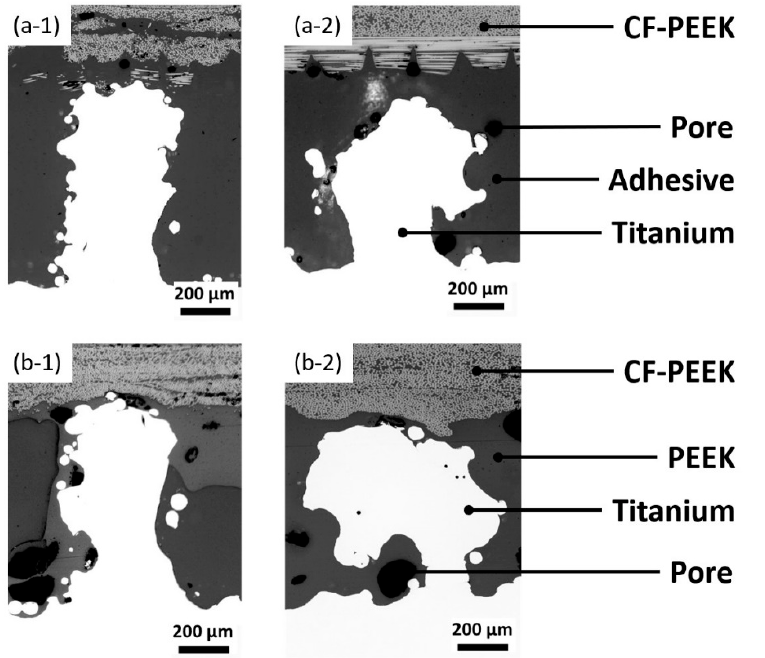
Figure 5. Metallographic cross section of ( a-1 ) and ( a-2 ) adhesive bonded and ( b-1 ) and ( b-2 ) ther- mally direct joined specimens with ( a-1 ) and ( b-1 ) groove-shaped and ( a-2 ) and ( b-2 ) pin-shaped surface structures .